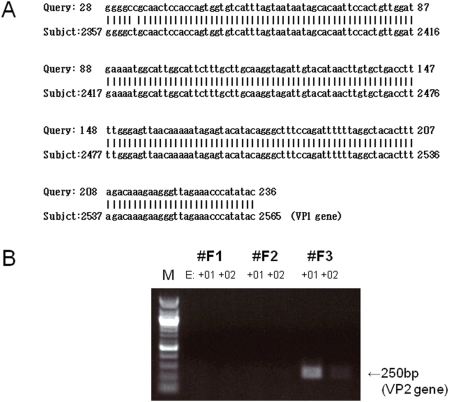
BLASTN (A) and PCR (B) analyses of WUV in Flu-positive nasopharyngeal aspirates.(A) Alignment of the WUV VP1 nucleotide sequence. The read obtained with the GS FLX sequencer (query) was compared with that of the WUV strain CLFF (subject; NCBI accession number: EU296475). (B) The WUV VP2 gene was detected by PCR using cDNA, which was amplified with random RT-PCR, as a template. The cDNA was diluted 10- and 100-fold and the PCR product was loaded on a 1% agarose gel. M indicates 100-bp DNA ladder.